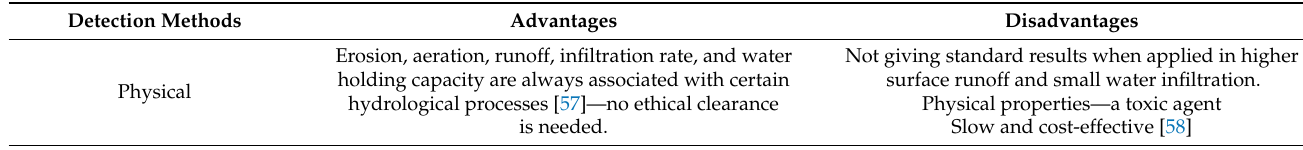
Table 2. Methods Used for Detection of Environmental